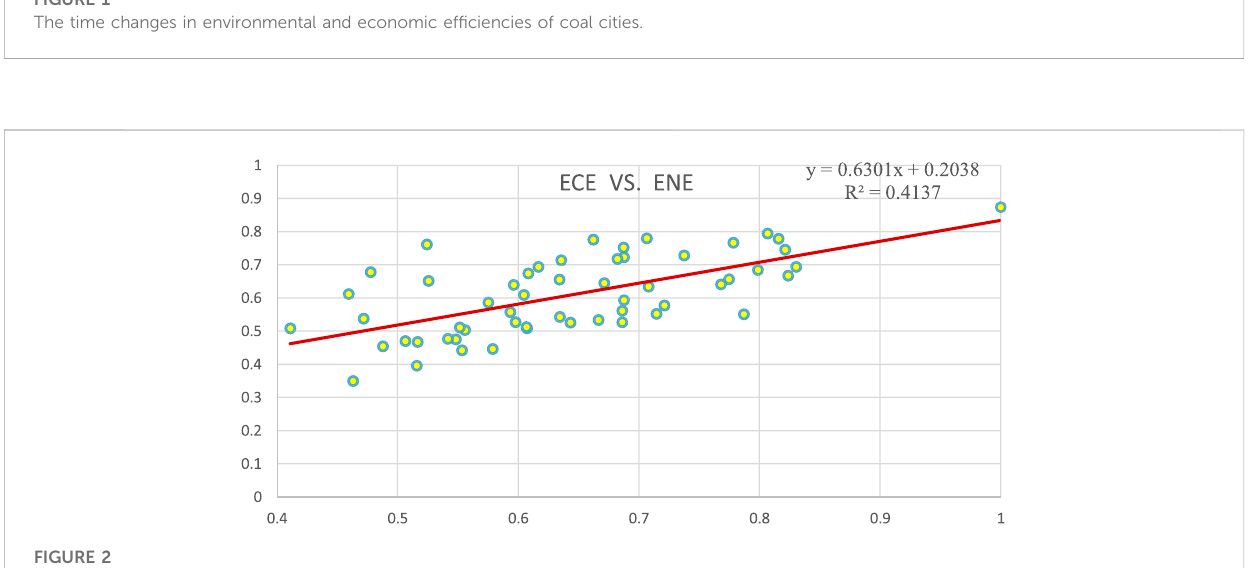
Correlation between economic ef fi ciency and environmental ef fi